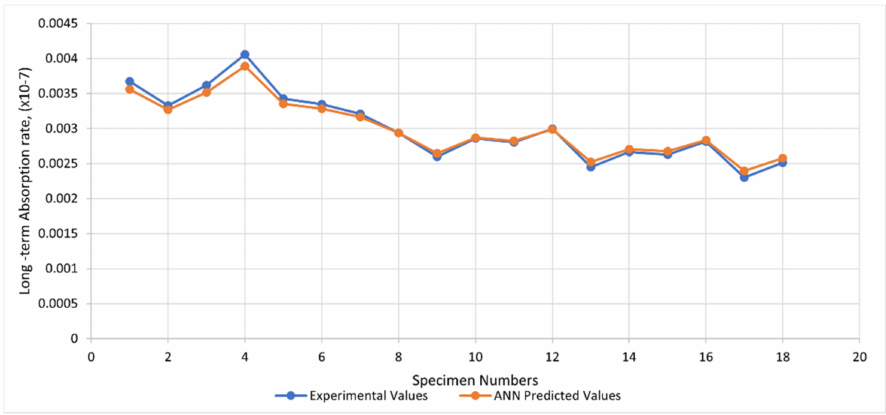
Figure 21. ANN vs. experimental—long-term absorption rate of test